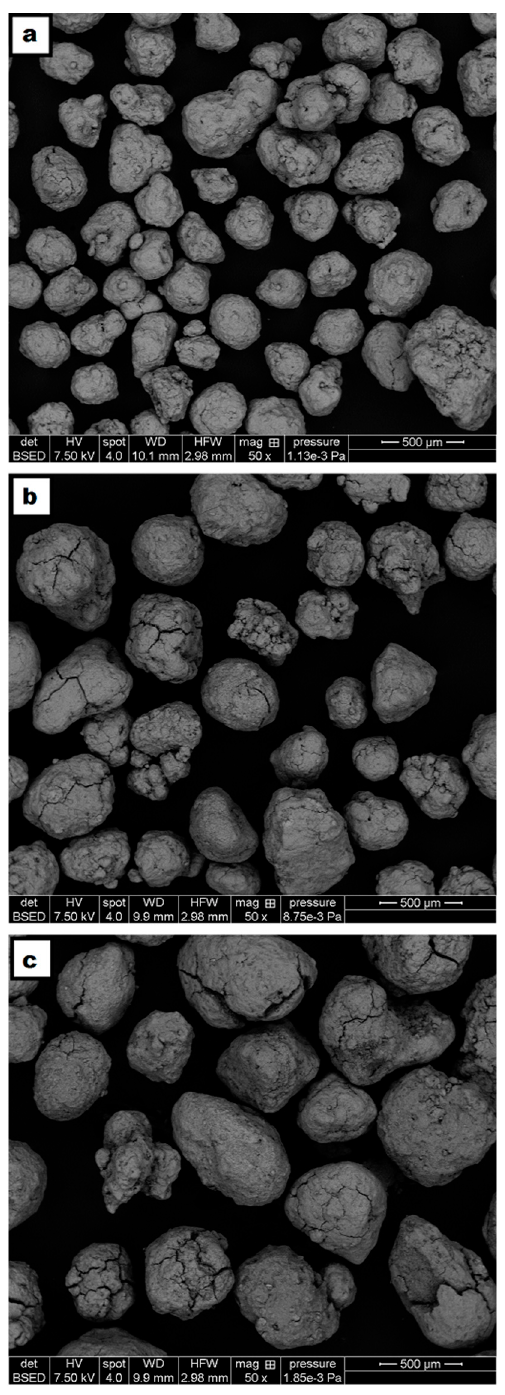
Figure 6. SEM micrographs of ( a ) CaO/CE as received; ( b ) CaO/CE-7.5N 2 at 0 cycle; and ( c ) CaO/CE-7.5N 2 at 20 cycles (carbonated).